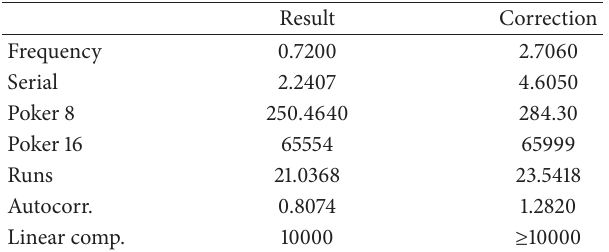
Table 2: RandTest statistical comparison.